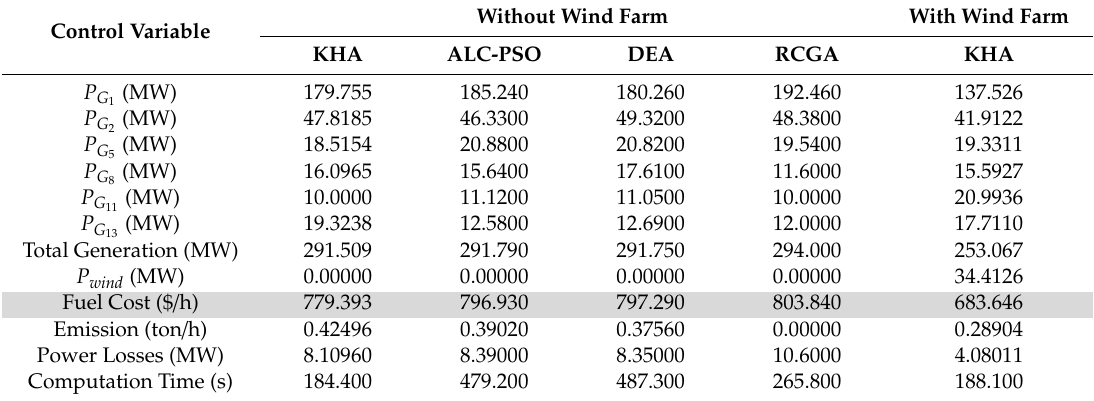
Table 3. Results for fuel cost minimization without considering the valve-point e ff ect for the Test System 1.